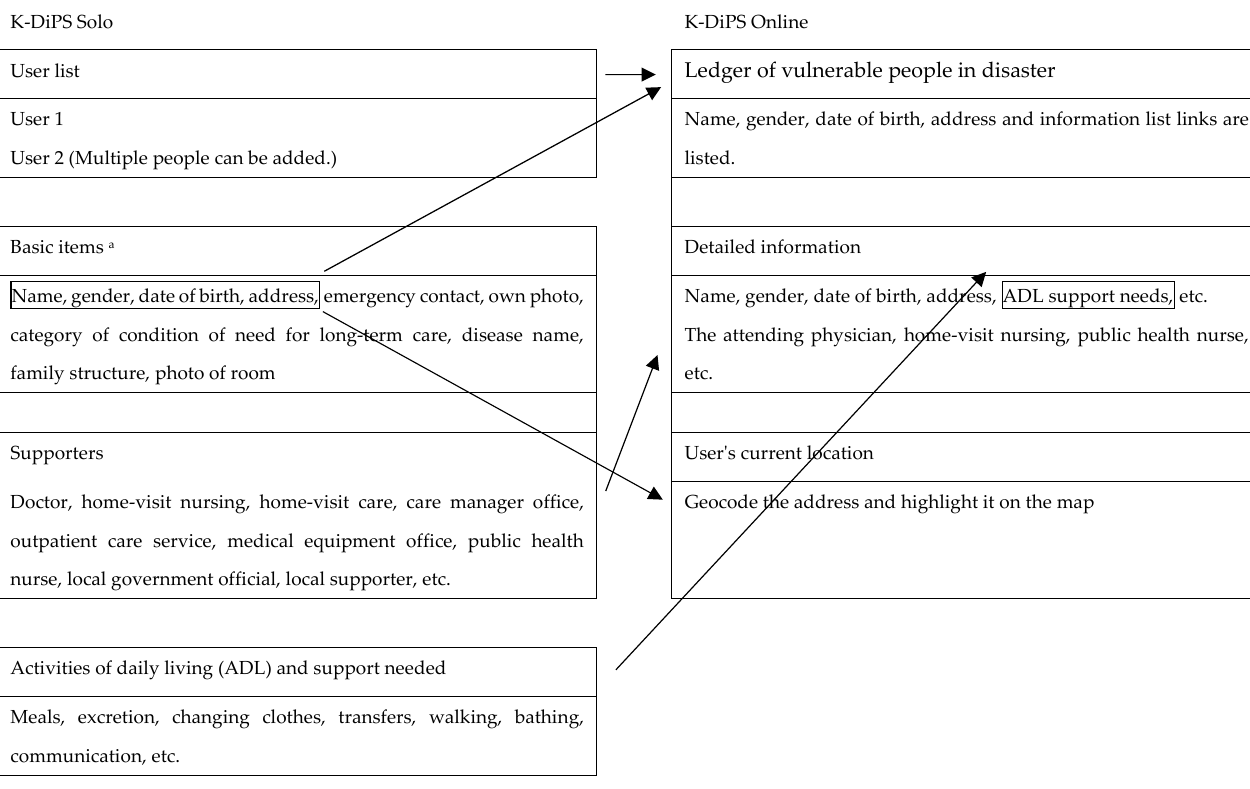
Figure 4. Basic information included in KDS and corresponding data in KDO. a The app contains a function to allow users to take a picture and save information.